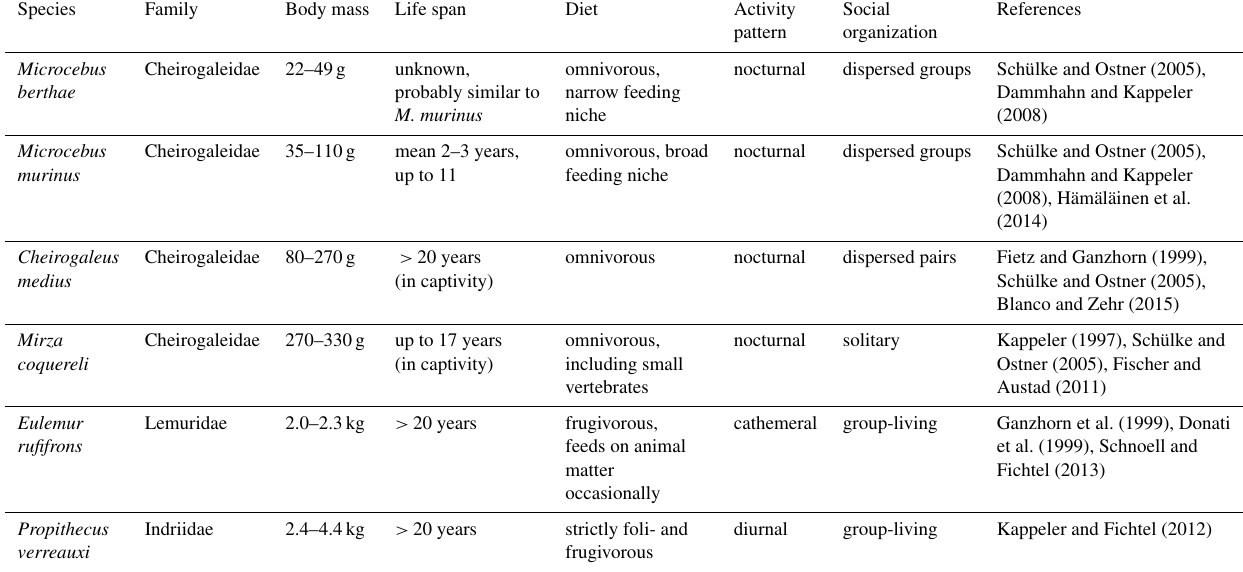
Table 1. Characteristics of six lemur species inhabiting Kirindy Forest,